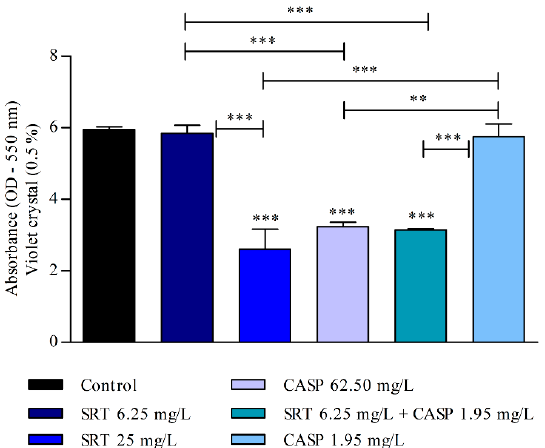
Figure 5. Effect of SRT, CASP, and SRT + CASP on the biomass of T. rubrum biofilm. Treatments were performed 7 days after the biofilm matured and stained with violet crystal. Significant differences between tested compounds and growth control were obtained using one-way ANOVA and Tukey’s post hoc test. Asterisks indicate statistical significance: ** p < 0.01 and *** p <